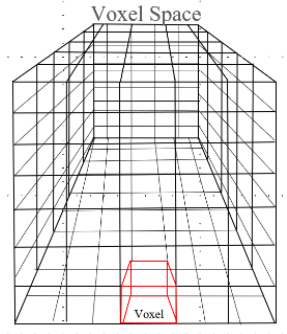
Figure 4: Example of voxel in a voxel space